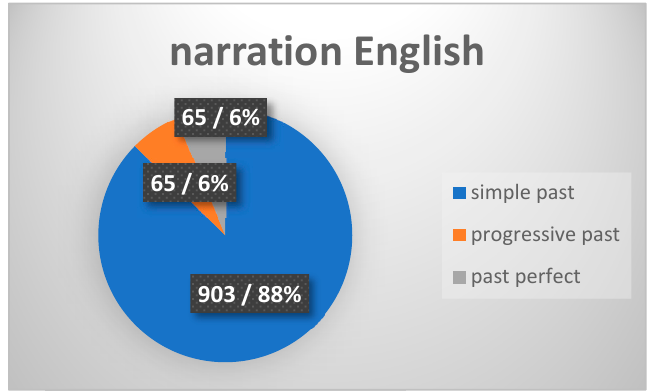
Figure 1. Distribution of English past forms in corpus A (narrative discourse).